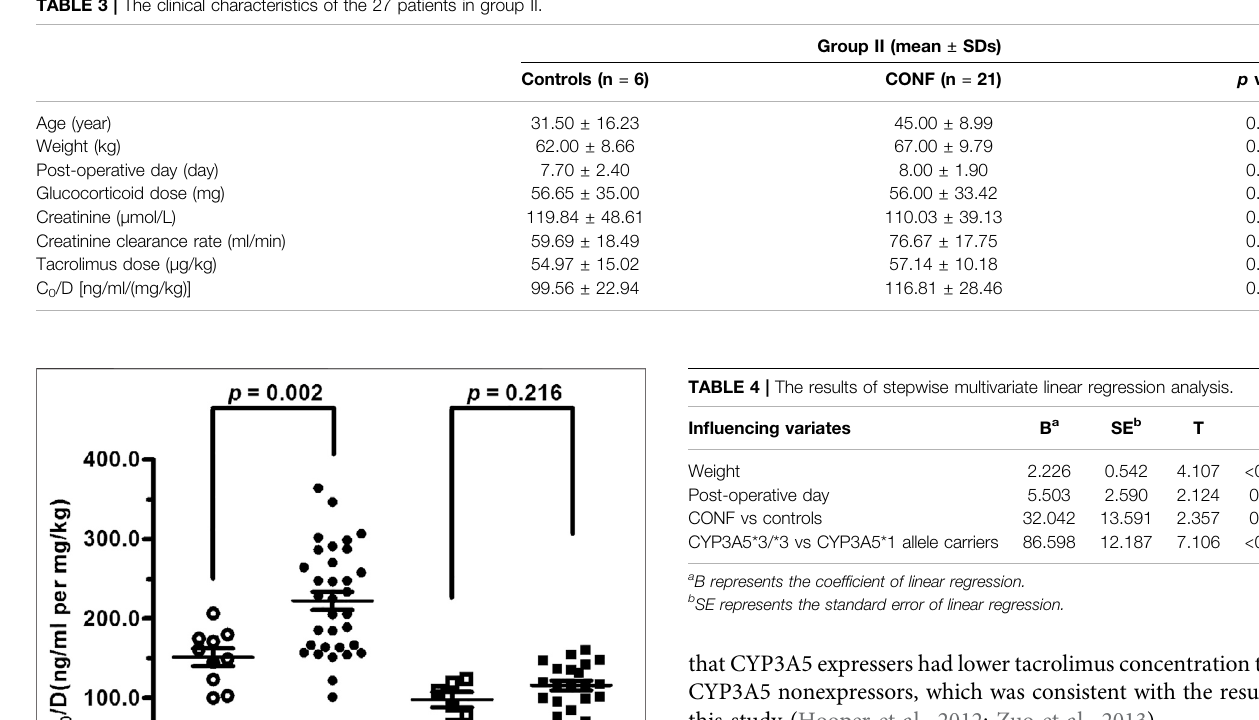
TABLE 3 | The clinical characteristics of the 27 patients in group II.